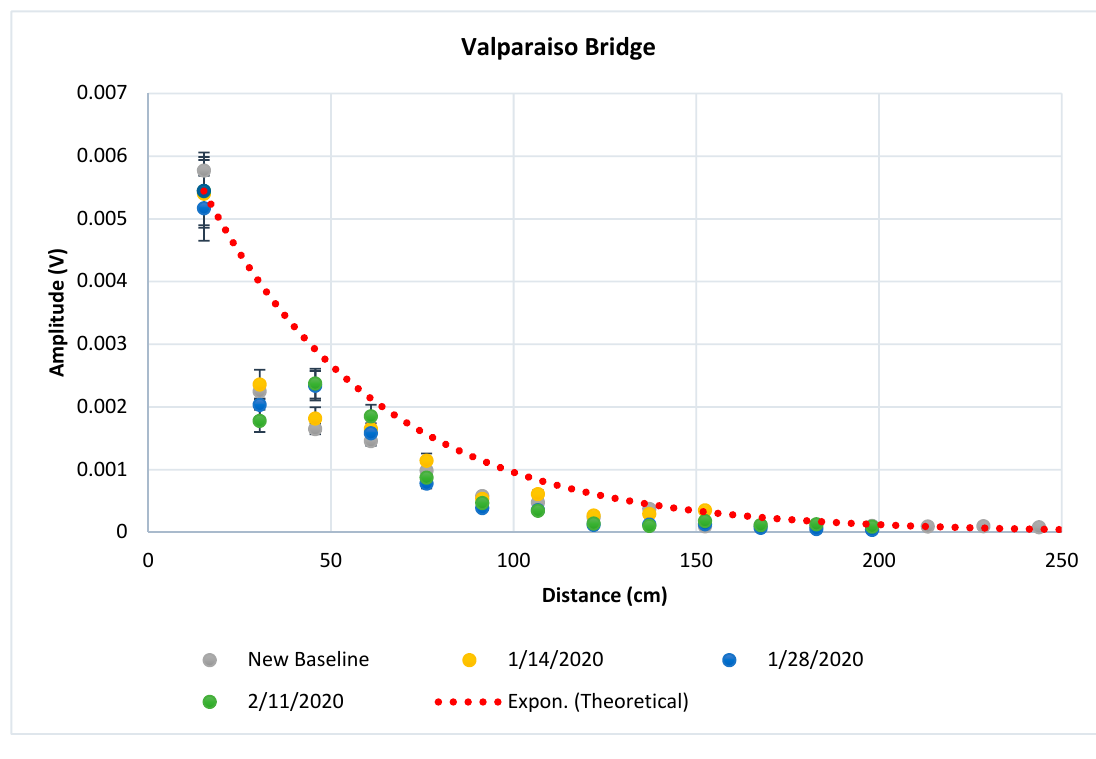
Figure 23. Baseline data versus other days for Valparaiso Bridge.